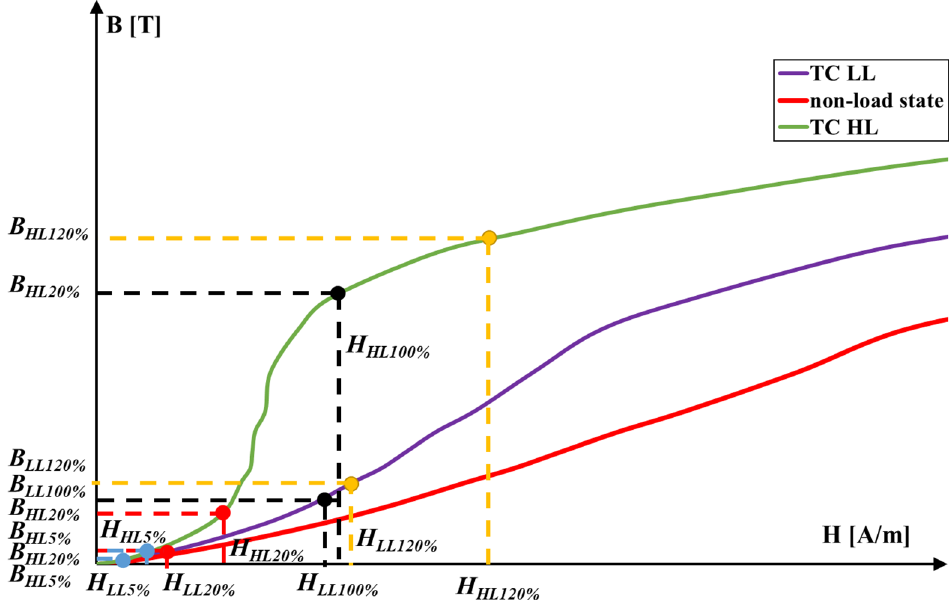
Figure 2. Operation points of the corrected inductive CT on the equivalent magnetization characteristic of the magnetic core [35]. Where: TC LL—equivalent magnetization characteristic of CT with applied turn correction determined for the low value of the load of the secondary winding; TC HL—equivalent magnetization characteristic of CT with applied turn correction determined for the high value of the load of the secondary winding; Non-load state—magnetization characteristic of the magnetic core determined in the non-load state of CT; B HL120% —the value of the magnetic flux density of the inductive CT obtained for 120% of the rated primary current and rated load of the secondary winding; B HL100% —the value of the magnetic flux density of the inductive CT obtained for 100% of the rated primary current and rated load of the secondary winding; B HL20% —the value of the magnetic flux density of the inductive CT obtained for 20% of the rated primary current and rated load of the secondary winding; B HL5% —the value of the magnetic flux density of the inductive CT obtained for 5% of the rated primary current and rated load of the secondary winding; B LL120% —the value of the magnetic flux density of the inductive CT obtained for 120% of the rated primary current and 25% of the rated load of the secondary winding; B LL100% —the value of the magnetic flux density of the inductive CT obtained for 100% of the rated primary current and 25% of the rated load of the secondary winding; B LL20% —the value of the magnetic flux density of the inductive CT obtained for 20% of the rated primary current and 25% of the rated load of the secondary winding; B LL5% —the value of the magnetic flux density of the inductive CT obtained for 5% of the rated primary current and 25% of the rated load of the secondary winding; H HL120% —the value of the